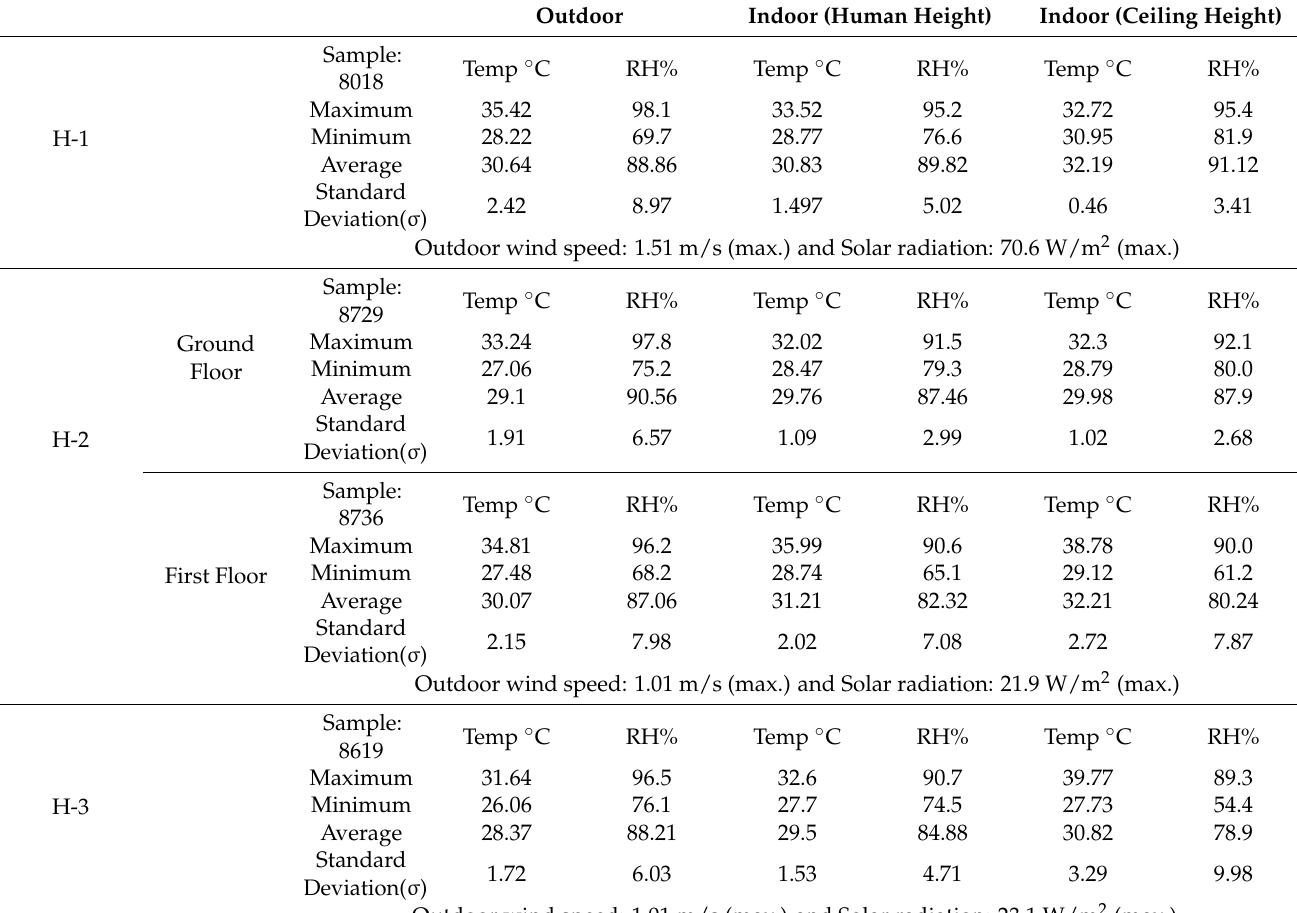
Table A1. Max., min and avg. AT and AH of H-1, H-2 and H-3 (Source: Field experiment).